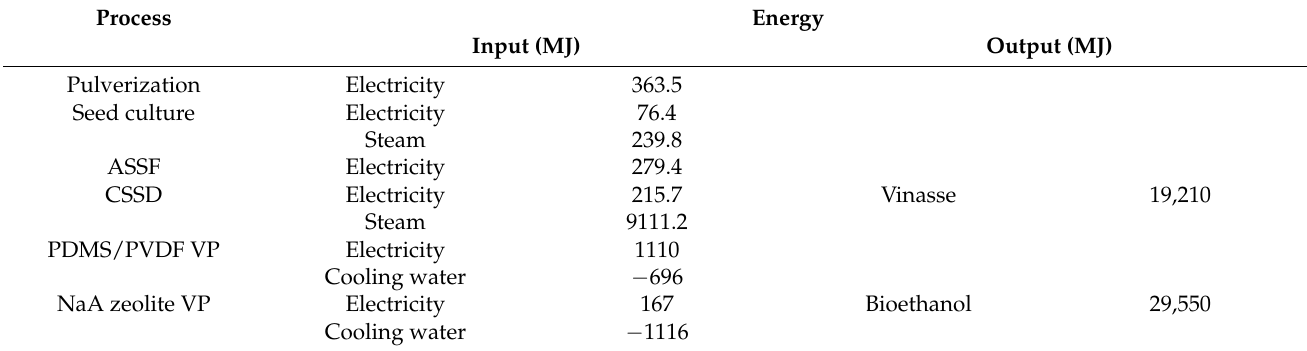
Table 3. Energy input and output of OPTS bioethanol process based on 1 ton product.